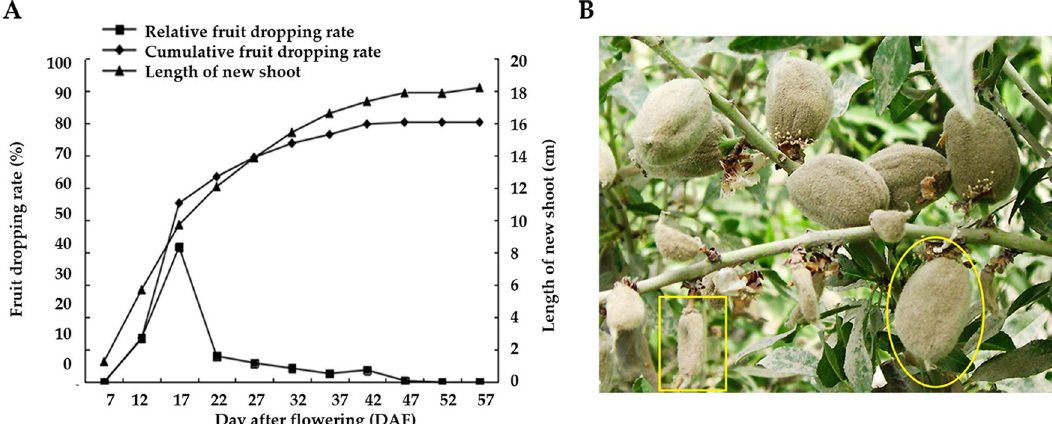
Figure 1. ( A ) Dynamic changes of almond shoots increment and fruit dropping rate; ( B ) Growth state of the fruits at 32 DAF. The yellow circle locates the normal fruits, and the yellow box locates the abnormal